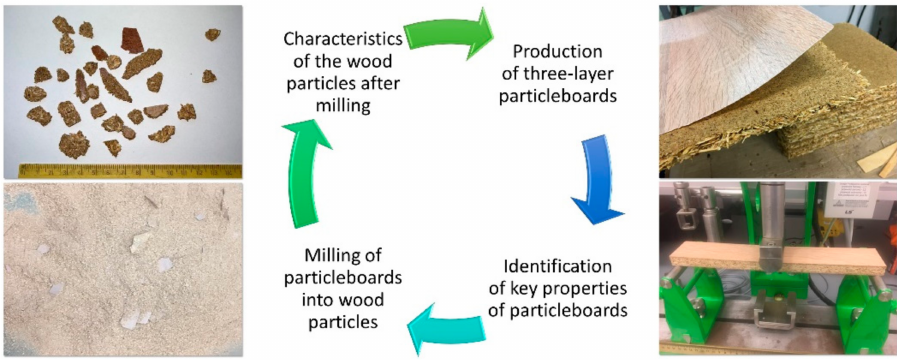
Figure 1. The general principle of the